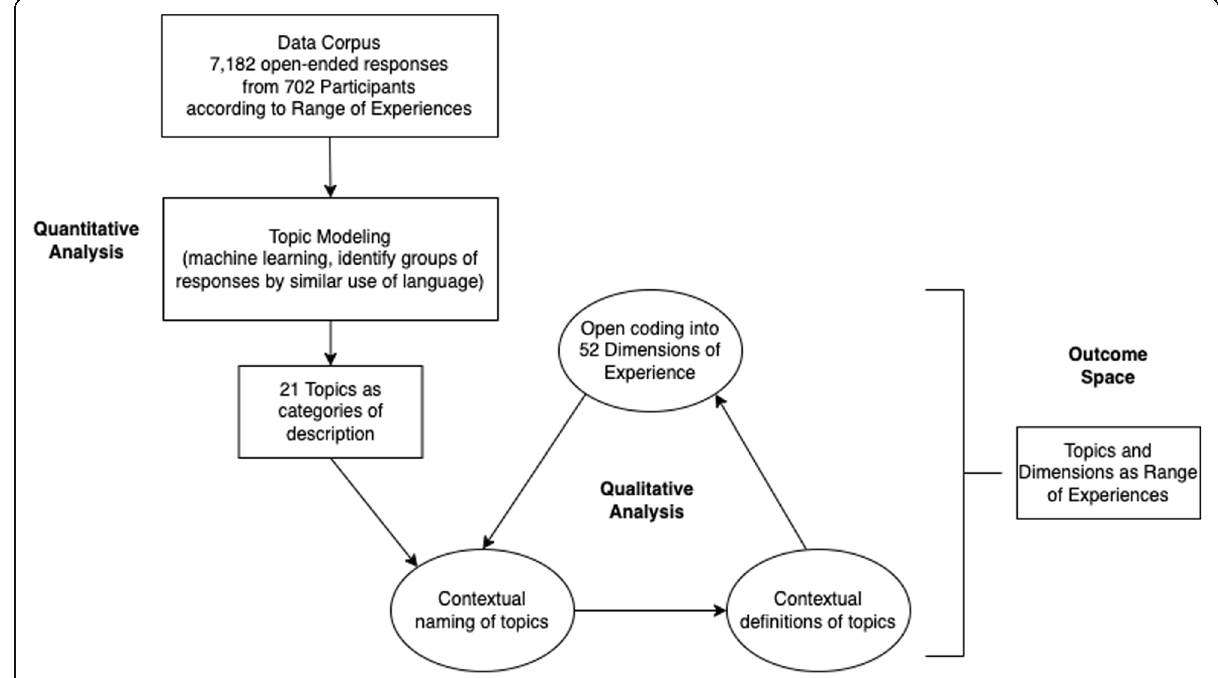
Fig. 1 The process of our sequential explanatory mixed